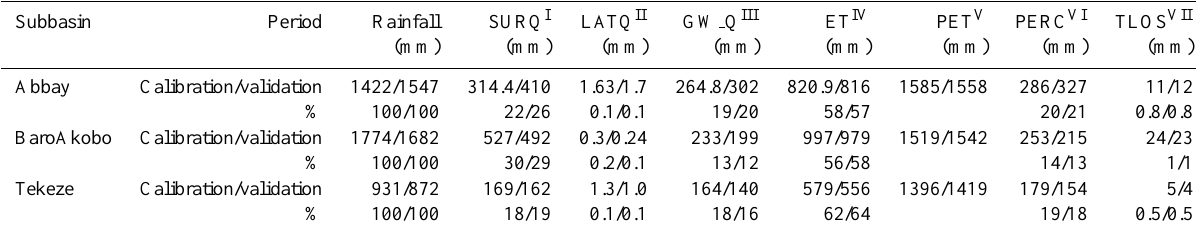
Table 8. Annual averaged calibrated/validated hydrological balances and percent contribution of water balance components for the Eastern Nile basin SURQ I : surface runoff, LATQ II : lateral flow into stream, GW Q III : groundwater in the shallow aquifer, ET IV : evapotanspi- ration, PET V : potential evapotranspiration (Hargreaves method is used), PERC VI : percolation below root zone (groundwater recharge), TLOS VII : transmission